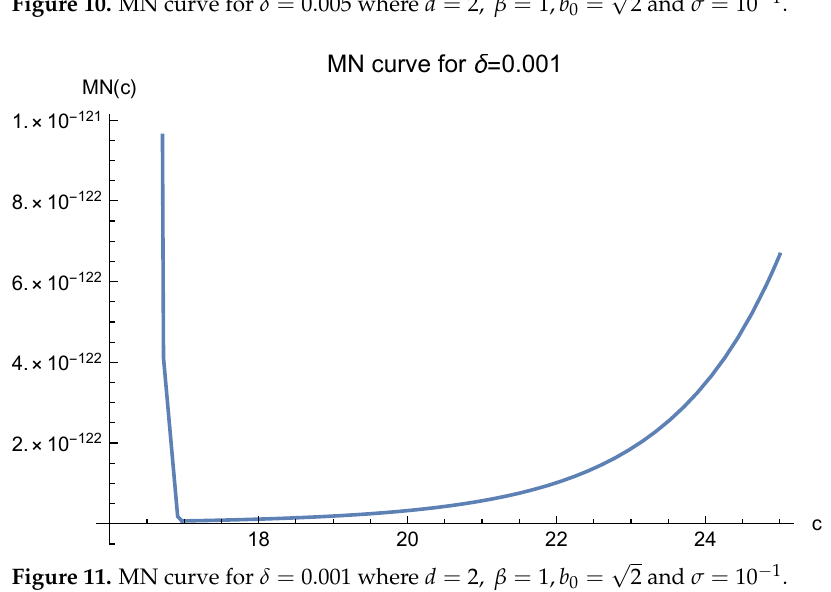
Figure 11. MN curve for δ = 0.001 where d = 2, β = 1, b 0 =